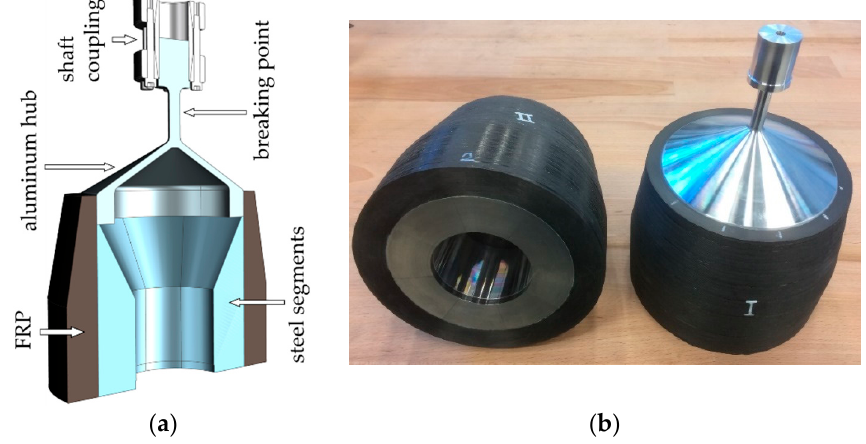
Figure 3. ( a ) Cross section of the specimen; ( b ) Assembled specimens.